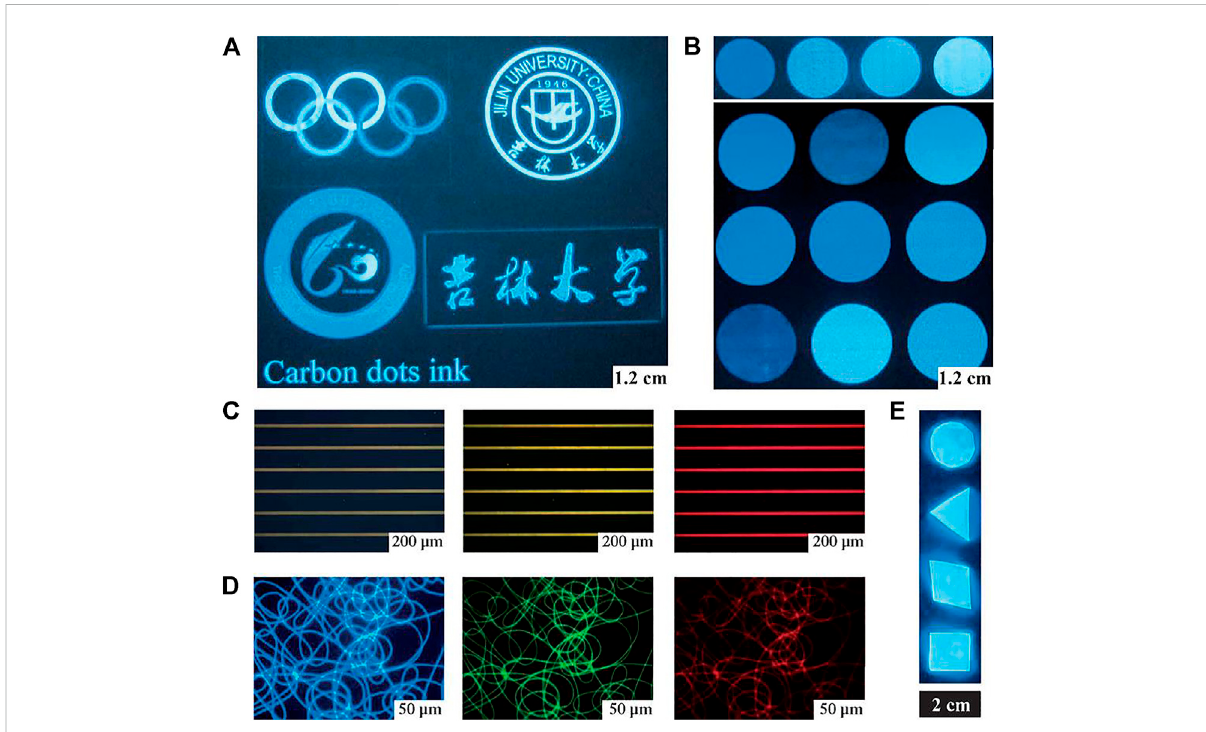
FIGURE 1 Printed patterns obtained by CD ink and the integration of CDs and polymers. (A) Different graphic patterns on paper (illuminated by a portable UVlamp). (B) Inks inmultiplecolors,tuned bytheCD concentration inaqueoussolution(illuminated byaportableUVlamp). (C) CDink patterned on hydrophilic photoetching stripes (under UV, blue, and green light excitation). (D) Fluorescence microscopy images of PVA/CD nano fi bers with UV, blue, and green light excitation. The fl uorescence microscopy images in (C) and (D) were obtained through band-pass fi lters of